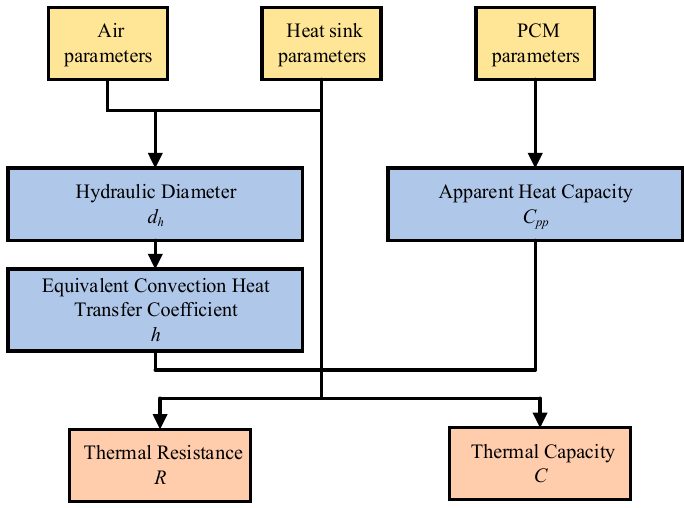
Figure 3. The flow chart of calculated thermal network parameters.